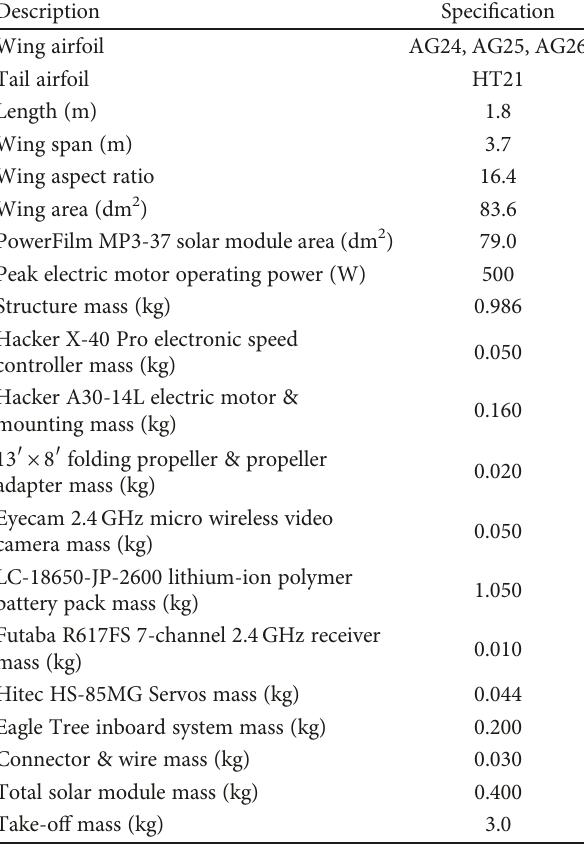
Table 2: Cran fi eld solar UAV speci fi cation.